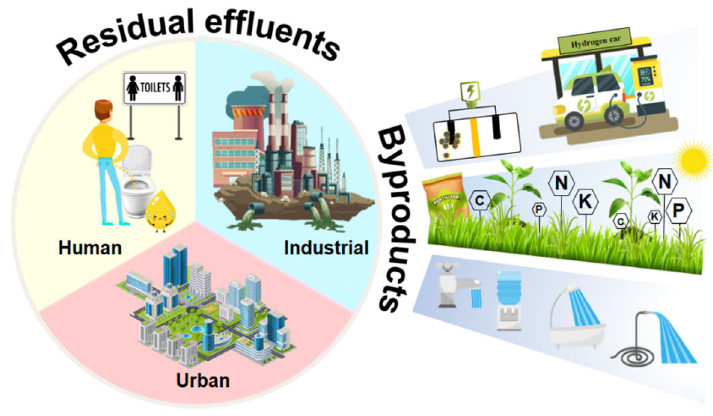
Figure 3. Residual effluents and their byproducts.